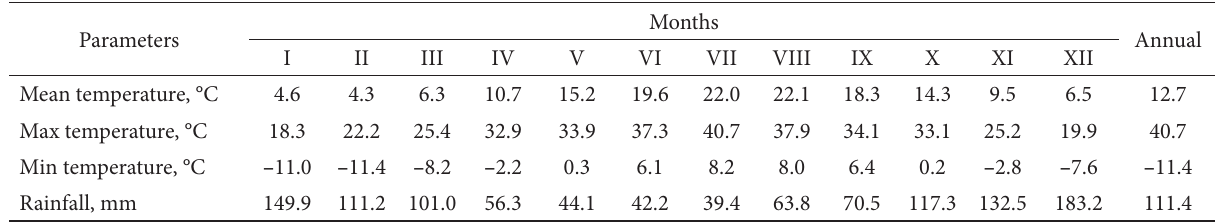
Max temperature,